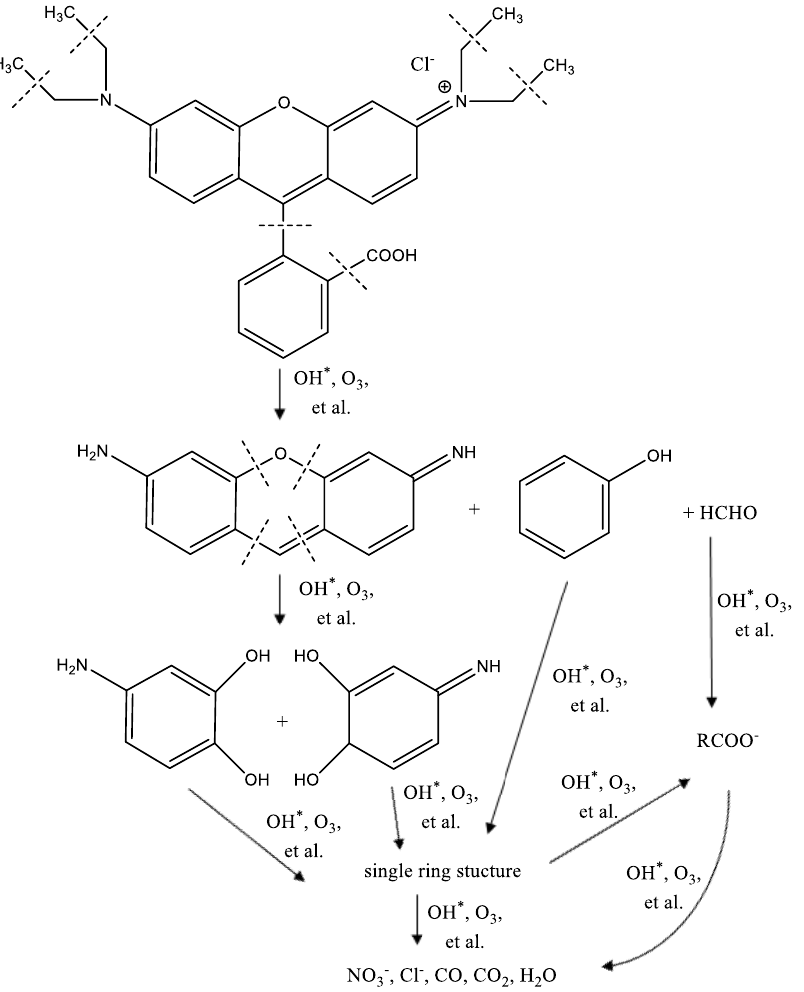
Figure 10. Proposed mechanism for the destruction of RhB.